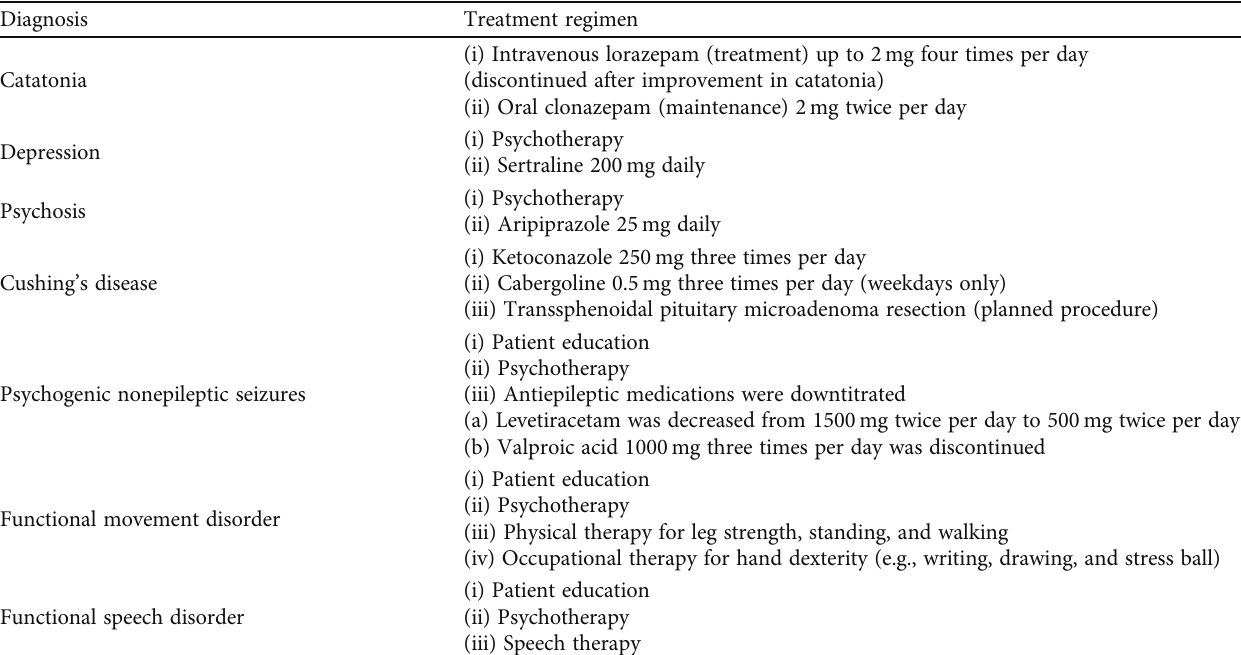
Table 1: Multidisciplinary treatments provided to a patient with Cushing ’ s disease presenting with functional neurological disorder.